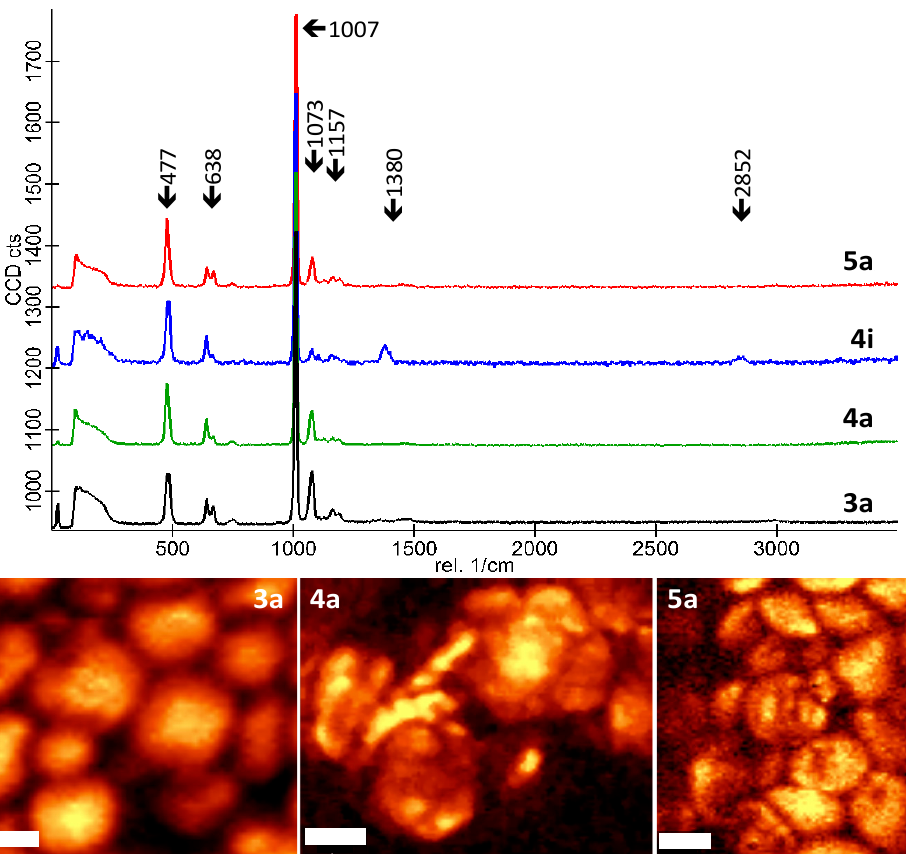
Figure 3. Raman spectra of the four distinct crystal morphologies: well-rounded crystals (sample 3a), rosette crystals (sample 4a), elliptical crystals (sample 4i), euhedral crystals (sample 5a). All of the spectra show typical Raman bands of barium sulfate with a strong band at 1007 cm − 1 and medium to weak bands at 477, 638, 1073, and 1157 cm − 1 . The differences in the spectra reflect changes in chemical composition due to addition of organics to the initial solution (sample 4i). Scale of all images is 5 µm.